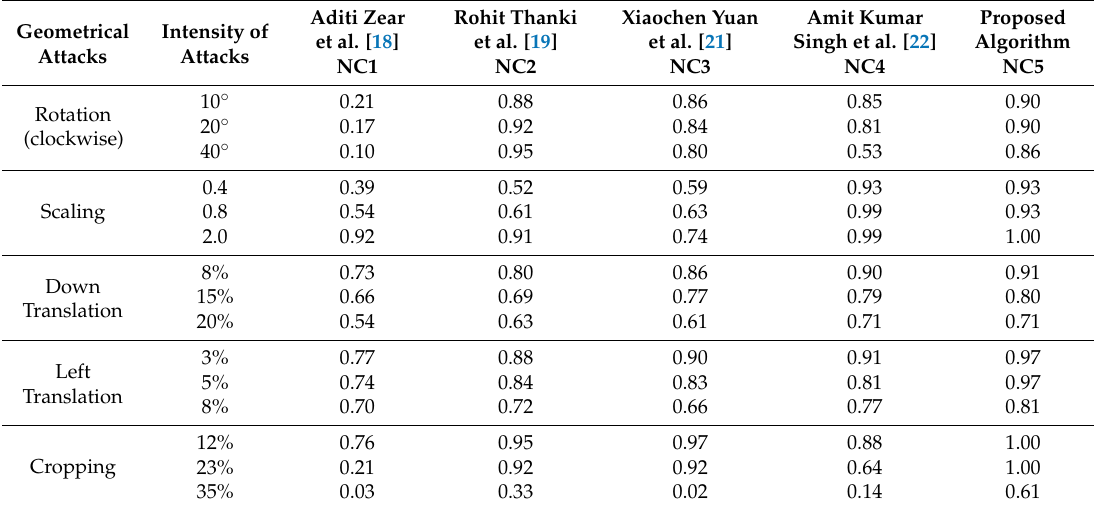
Table 12. Comparison values of different algorithms under geometric